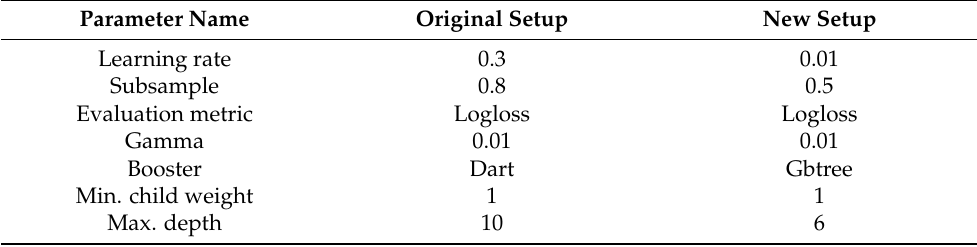
Table 3. Parameter setup for the XGBoost model.